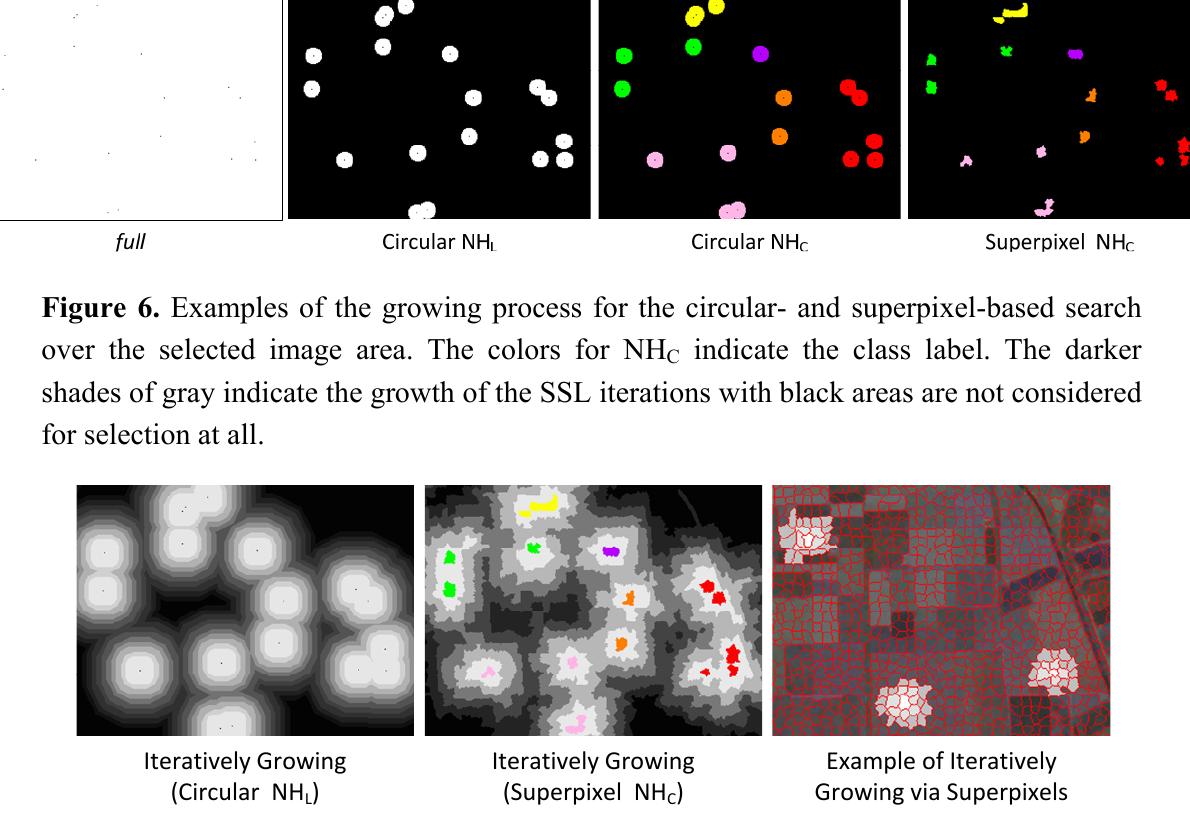
Figure 5. Examples of the different initial search neighborhoods for the unlabeled sample selection over the selected image area. The colors for NH